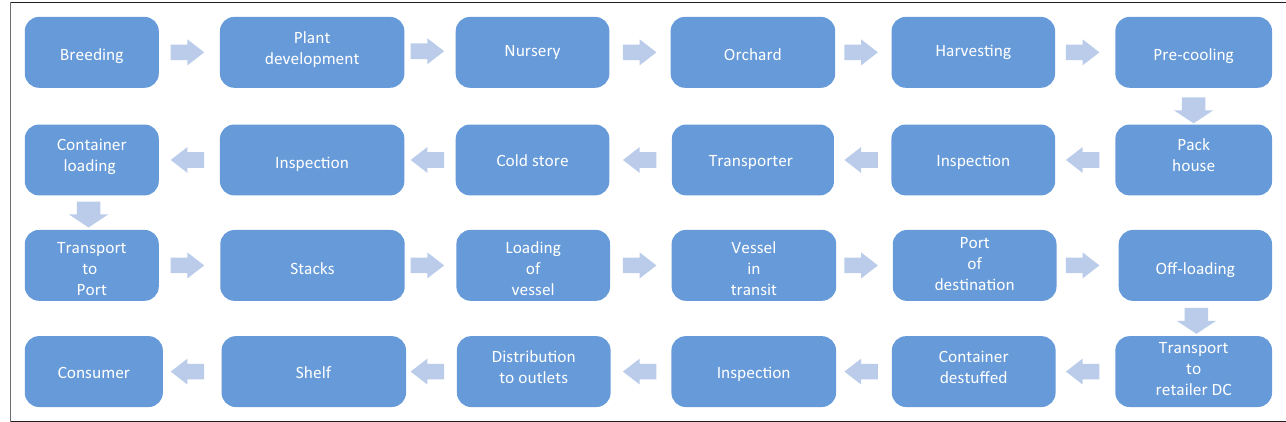
FIGURE 2: Generic deciduous cold-chain flow